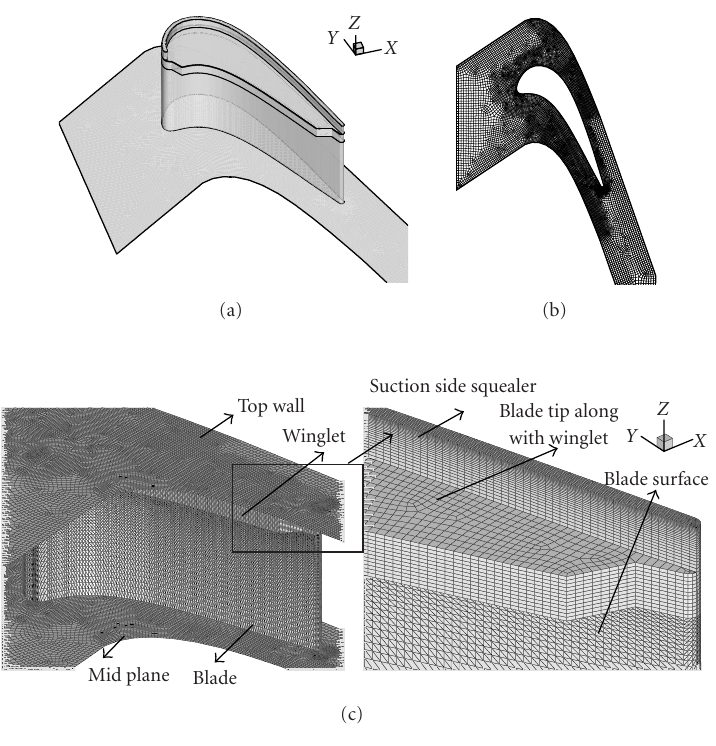
Figure 2: (a) Geometry of the model, (b) grid distribution at the mid-span, and (c) three-dimensional view of the grid and zoomed-in view near the suction-side squealer tip with